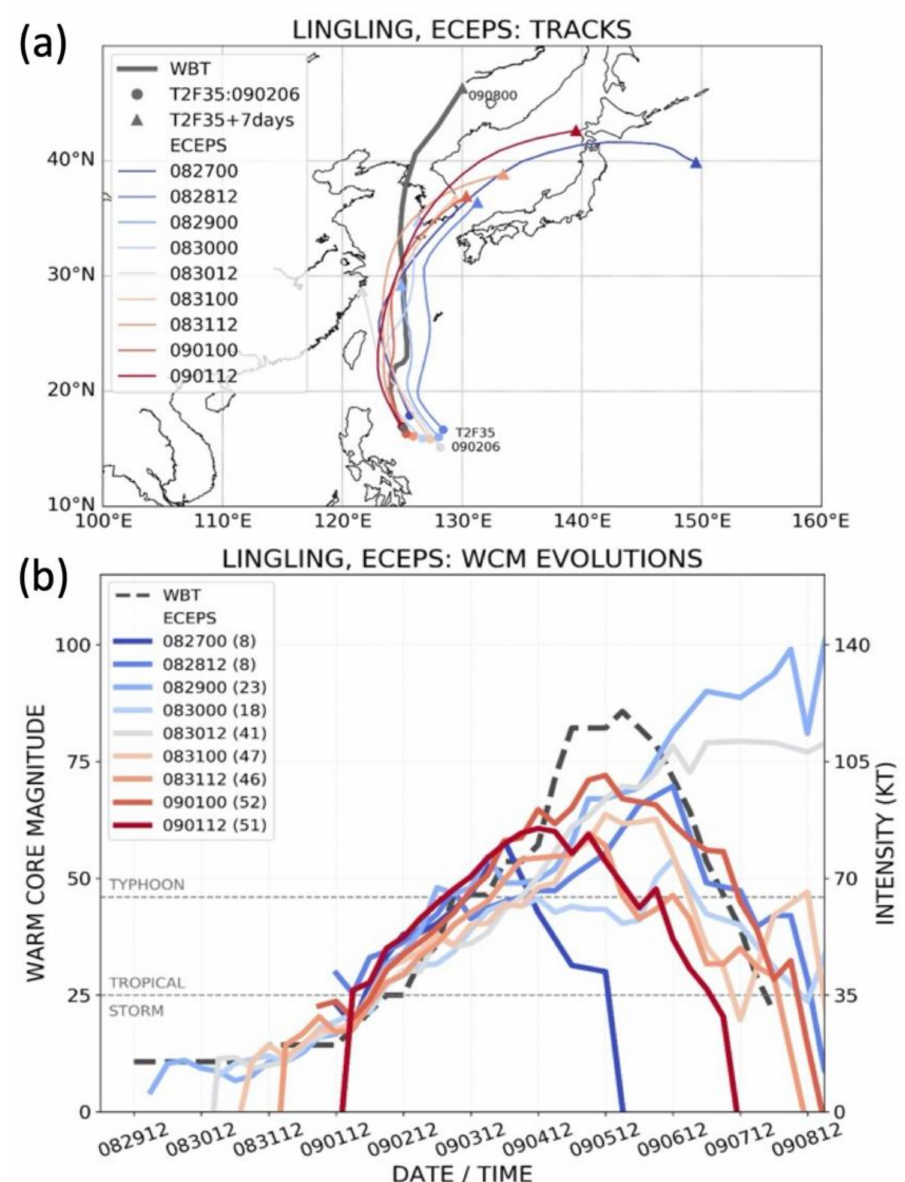
Figure 1. ( a ) A sequence of ECEPS WMVM track forecasts initiated from the month-day-hour (MMDDHH) in the inset, with origins (colored dots) at the T2F (35 kt) of 06 UTC 2 September 2019 for the pre-Typhoon Lingling circulation and ending points (colored triangles) seven days after the T2F (35 kt) compared with the JTWC Working Best-track (WBT, solid black line) with ending time of 00 UTC 8 September. ( b ) ECEPS-predicted Warm Core Magnitude evolutions (left ordinate) along the WMVM track forecasts for the dates and times in panel ( a ) and the JTWC WBT intensity (kt, black dashed line, right ordinate). The calibrated WCM threshold values of 25 for a Tropical Storm and 46 for a Typhoon are indicated along the left ordinate and by the horizontal thin dashed lines (see